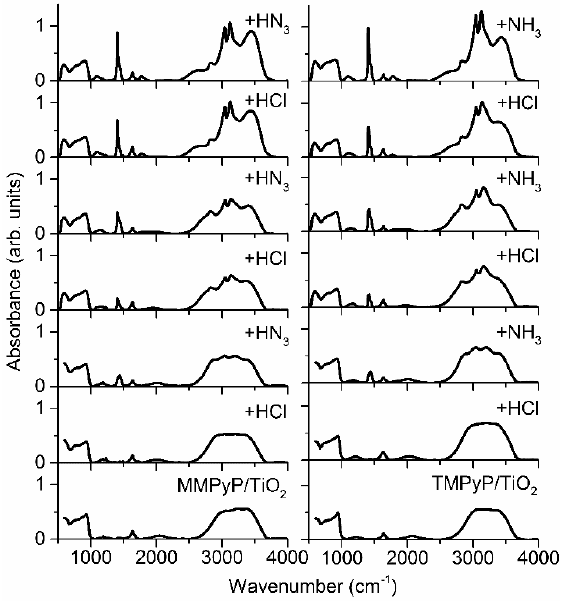
Figure 8. Infrared spectra of the MMPyP/TiO 2 ( left ) and TMPyP/TiO 2 ( right ) composites under successive exposure cycles to HCl and NH 3 . Number of exposures increases from bottom (unexposed samples) to top.